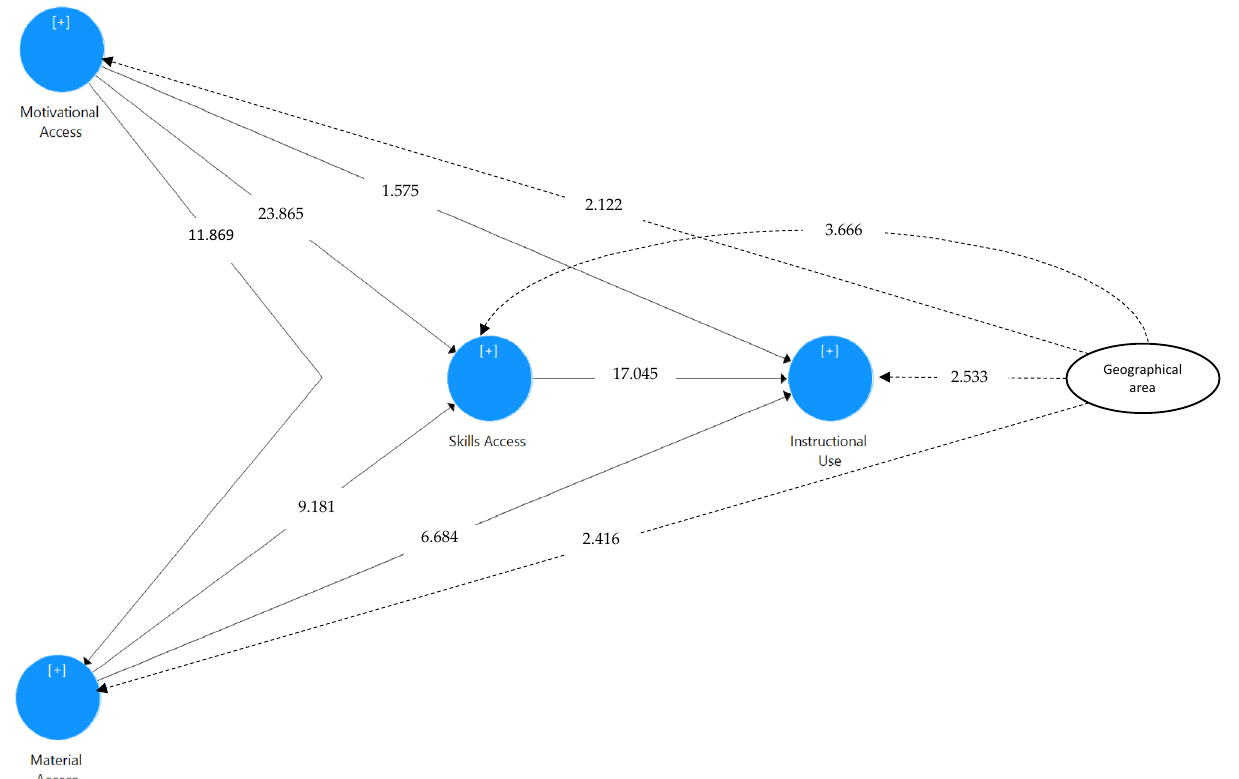
Figure 3. Structural model